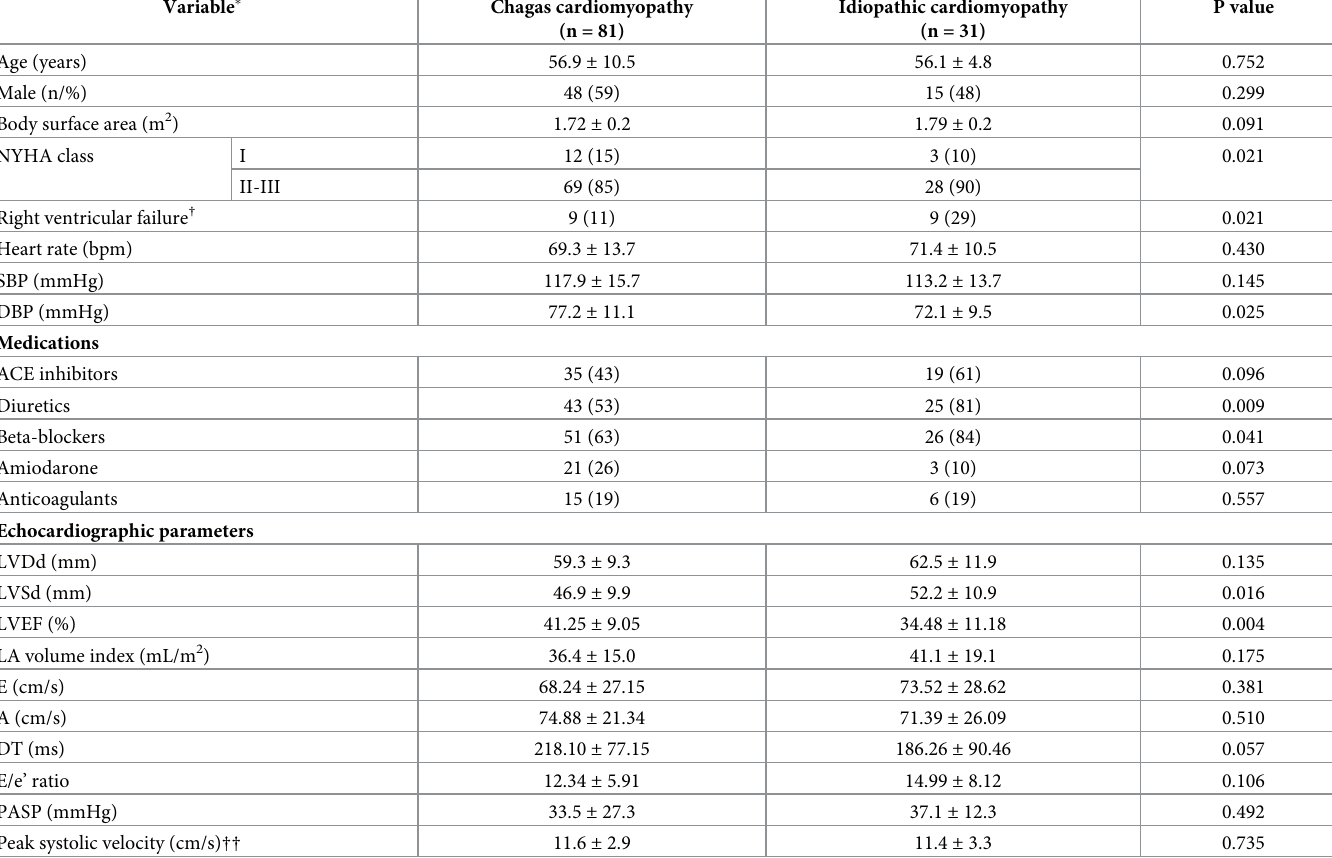
Table 1. Clinical features of the patients stratified according to underlying cause of cardiomyopathy. Variable